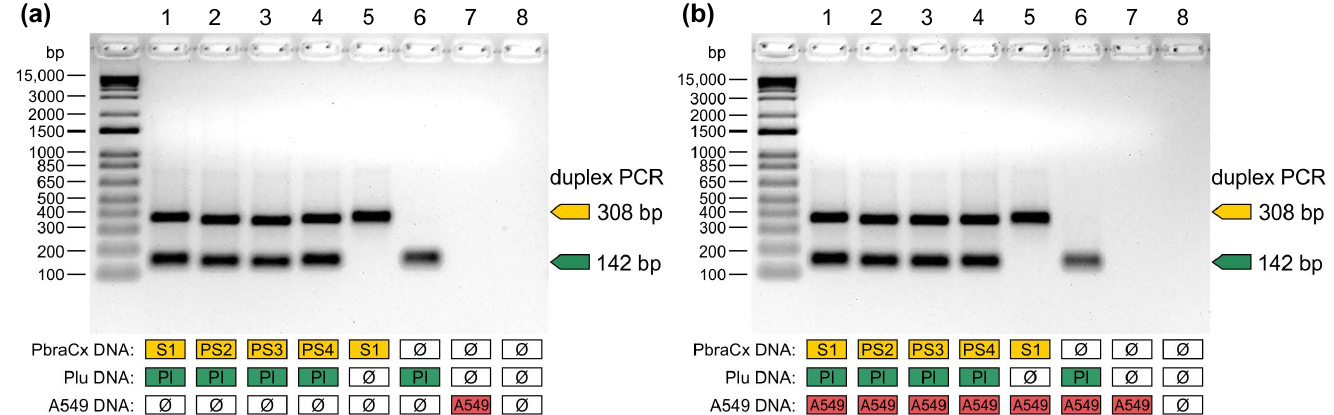
Figure 4. The specificity of Paracoccidioides duplex assay in the presence of non-target templates. ( a ) A pooled DNA sample comprising equal amounts of members of the P. brasiliensis complex and P. lutzii . To confirm the specificity of amplification, we removed the target DNA from the pooled sample. Lane 1a: Pb18 (S1) and Pb01 ( P. lutzii ); Lane 2a: EPM204 (PS2) and Pb01; Lane 3a: EPM77 (PS3) and Pb01; Lane 4a: EPM73 (PS4) and Pb01; Lane 5a: Pb18, EPM204, EPM77, and EPM73; Lane 6a: Pb01; Lane 7a: A549 cells; Lane 8a: negative control. ( b ) A pooled DNA sample comprised equal amounts of members of the P. brasiliensis complex, P. lutzii , and DNA from A549 cells, a cell line derived from a human pulmonary adenocarcinoma. The absence of cross-reactions with human DNA was confirmed by removing Paracoccidioides DNA from the pooled sample. Lane 1b: Pb18 (S1), Pb01 ( P. lutzii ), and A549 cells; Lane 2b: EPM204 (PS2), Pb01, and A549 cells; Lane 3b: EPM77 (PS3), Pb01, and A549 cells; Lane 4b: EPM73 (PS4), Pb01, and A549 cells; Lane 5b: Pb18, EPM204, EPM77, EPM73, and A549 cells; Lane 6b: Pb01 and A549 cells; Lane 7b: A549 cells; Lane 8B: negative control. Data are representative of two independent experiments.